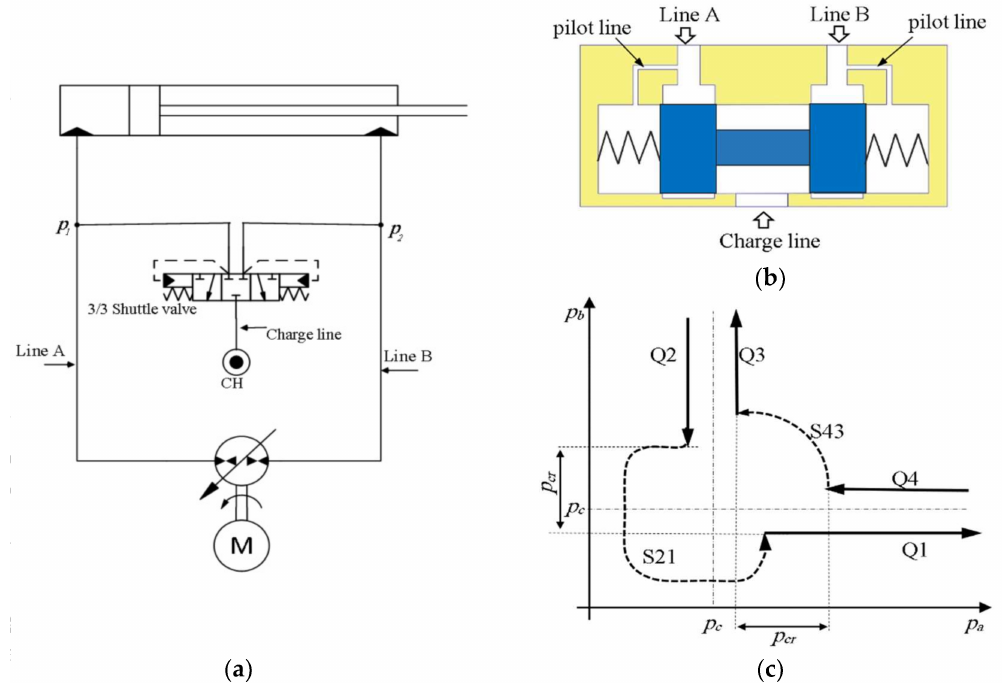
Figure 6. Circuit equipped with shuttle valve to compensate for cylinder differential flow: ( a ) schematic drawing of the circuit; ( b ) drawing of closed-center shuttle valve (CC-SHV); ( c ) expected pressure plane performance at critical